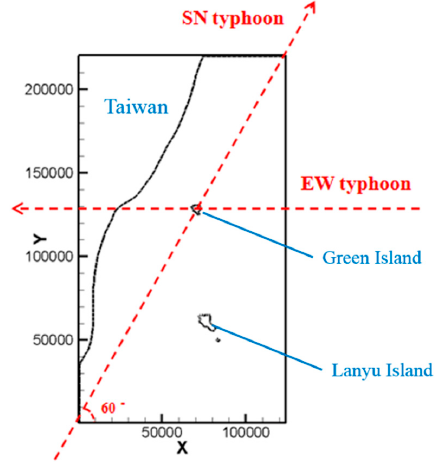
Figure 9. Schematic diagram of the study domain and track of SN and EW typhoon.